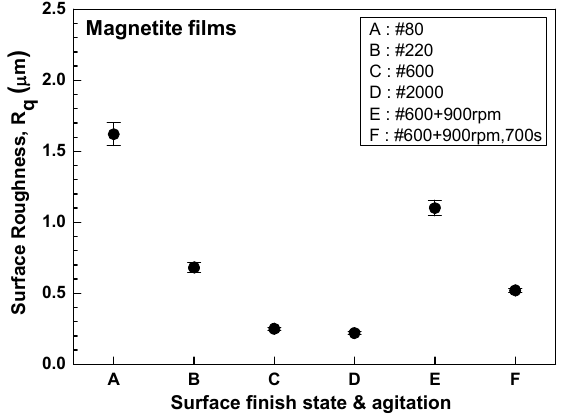
Figure 10. Surface roughness of magnetite films on carbon steel substrates with different roughnesses and agitation speeds.